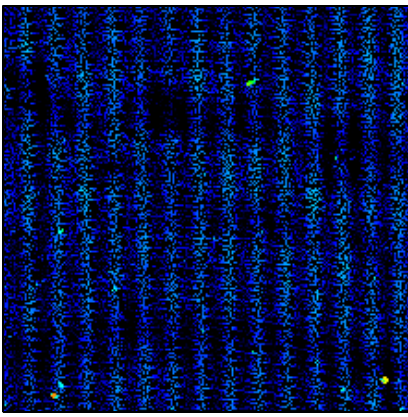
Figure 8. Abbott – Firestone curve( a ) for base surface and ( b ) after burnishing 𝑃 = 60 N , 𝑓 = 1000 mm/min (experimental run no. 8).